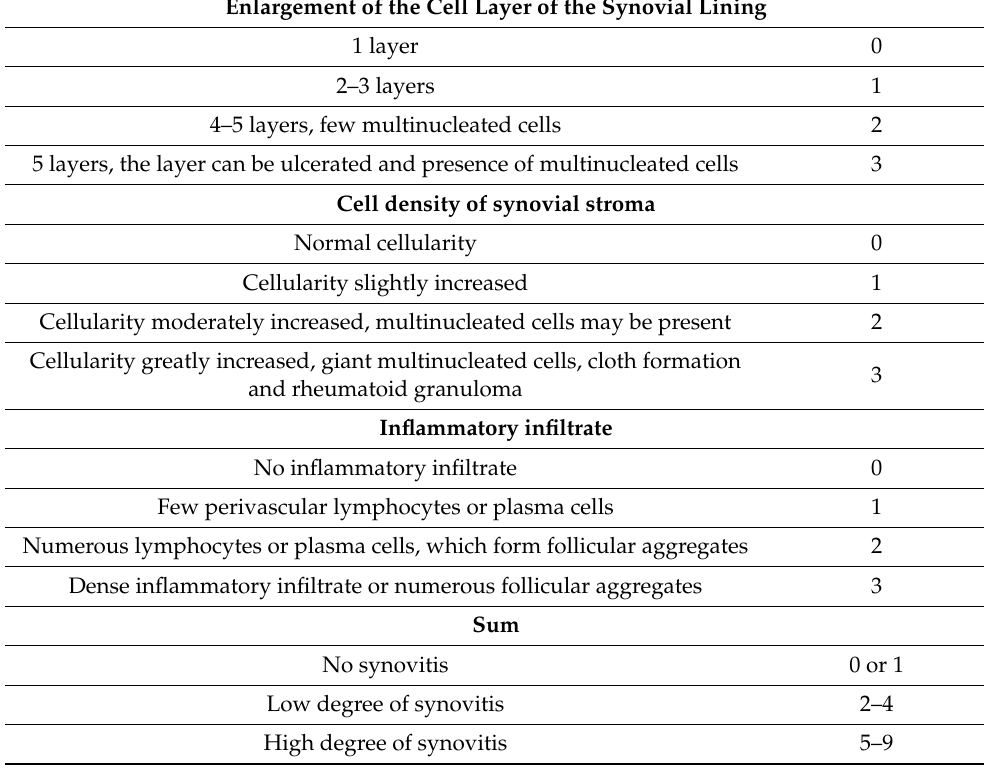
Table 2. Krenn score for the synovial membrane. Each total score is the sum of the subscores. Minimum = 0; maximum =